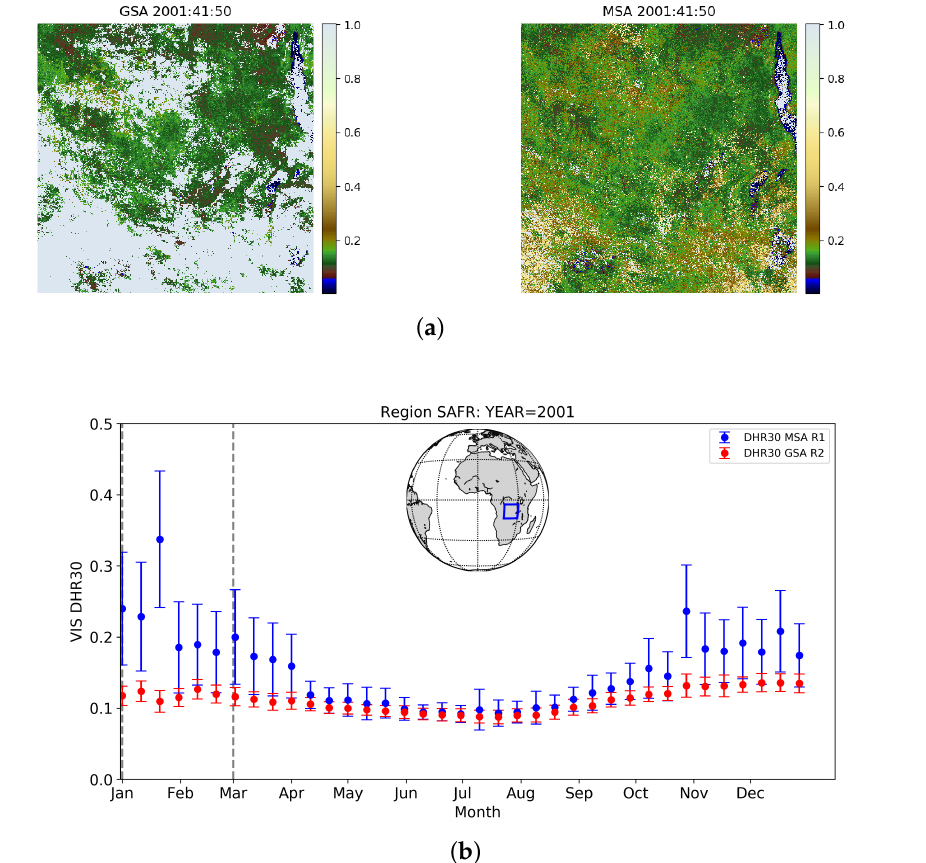
Figure 4. Southern Africa (SAFR) region. On the bottom plot ( b ), comparison of VIS DHR30 as retrieved in the region north of Equator from MSA Release 1 (blue) and GSA Release 2 (red). The season of interest is included between the two dashed vertical lines. On the upper panel ( a ) map comparison between GSA Release 2 (bottom left panel) and MSA Release 1 (bottom right panel) for the period 041–050 (10 to 20 of February)